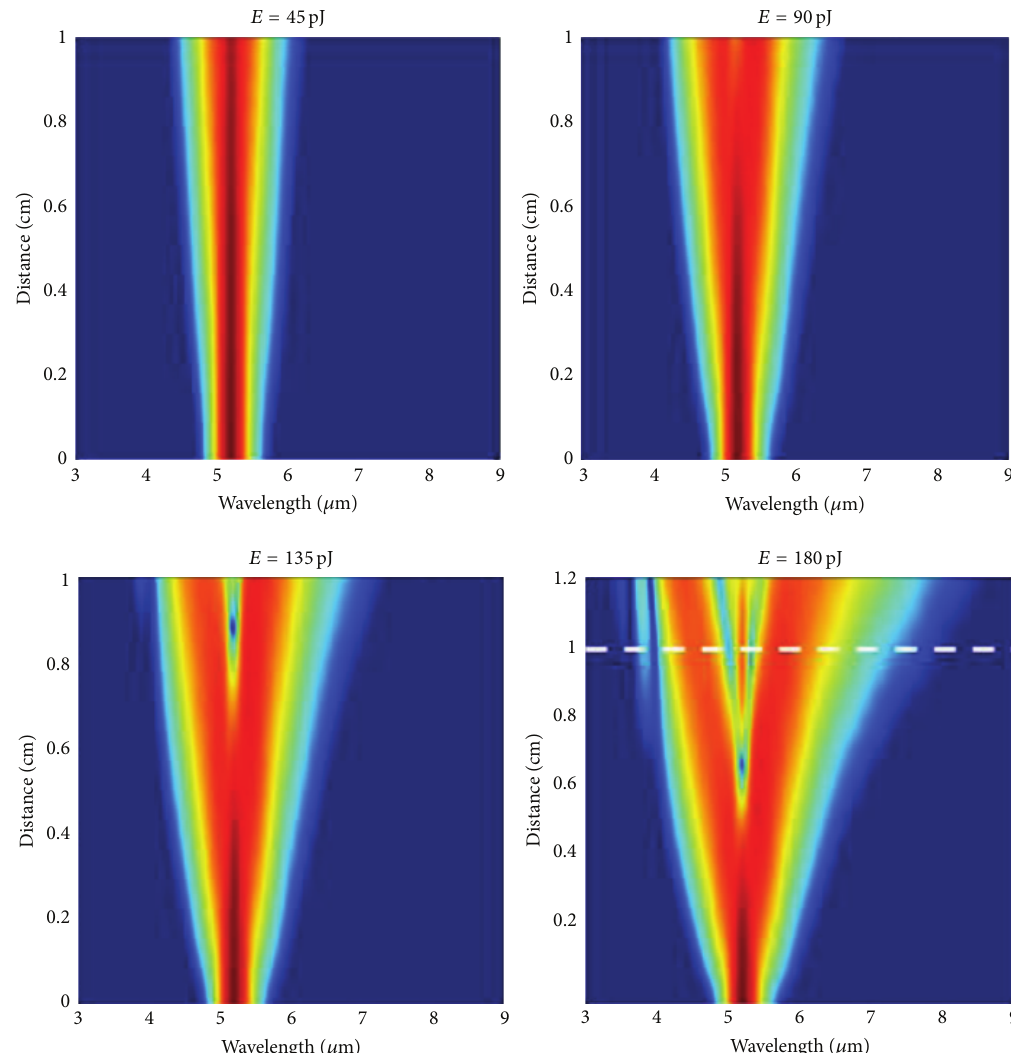
Figure 4: Supercontinua generated in As 2 Se 3 -based PCF with 𝑑 = 2𝜇 m and Λ = 5 𝜇 m and calculated for different energies of (a) 45 pJ, (b) 90 pJ, (c) 135pJ, and (d) 180pJ. The input pulse has a FWHM of 160fs. –––Maximum broadening for 1cm PCF length with 180 pJ input energy (i.e., 1 kW peak